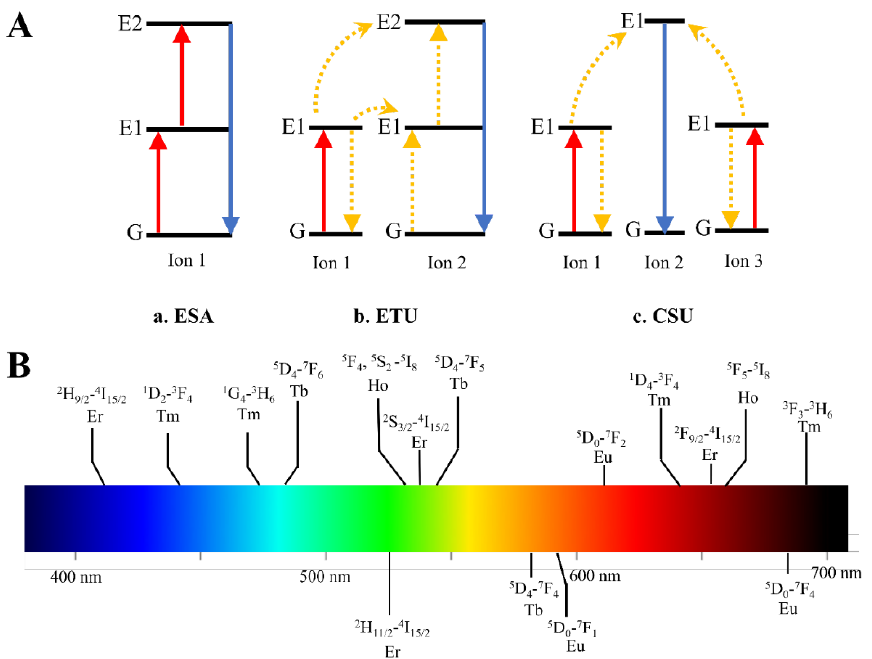
Figure 2. ( A ) Scheme of upconversion mechanisms. ( a ). ESA: Excited State Absorption, ( b ). Energy Transfer upconversion, ( c ). Cross Relaxation. G: ground state. E1: intermediate state. E2: excited state. Red line: photo excitation process. Blue line: emission process. Yellow dashed line: energy transfer process. ( B ) The wavelength of the emitted photons from the transition of lanthanide ions can be varied from 400 nm to 700 nm (as is shown in color bar), which shows the tunability of different lanthanide ions (reproduced with permission from [16]).